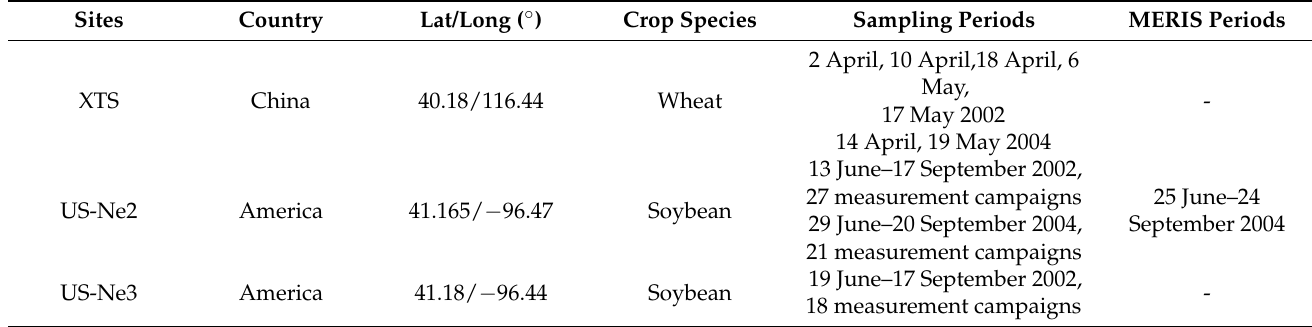
Table 1. Details of the study sites, including the sampling locations (Lat = latitude; Long = longitude), crop species, sample periods and dates for the MERIS image